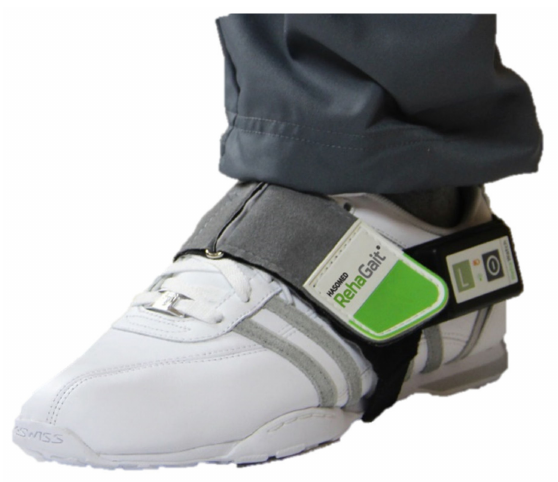
Figure 2. Inertial measurement unit with fixation